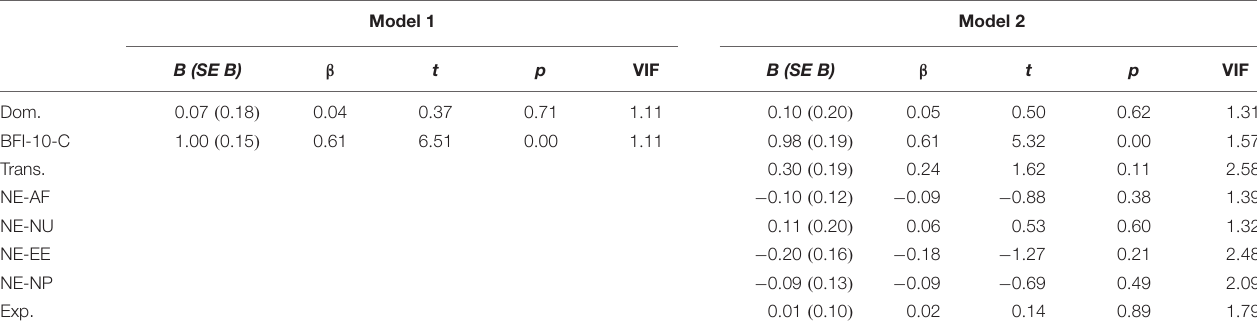
TABLE 4 | Hierarchical regression analysis predicting participants’ rating of conscientiousness in comparison to others (SCIS) for Study